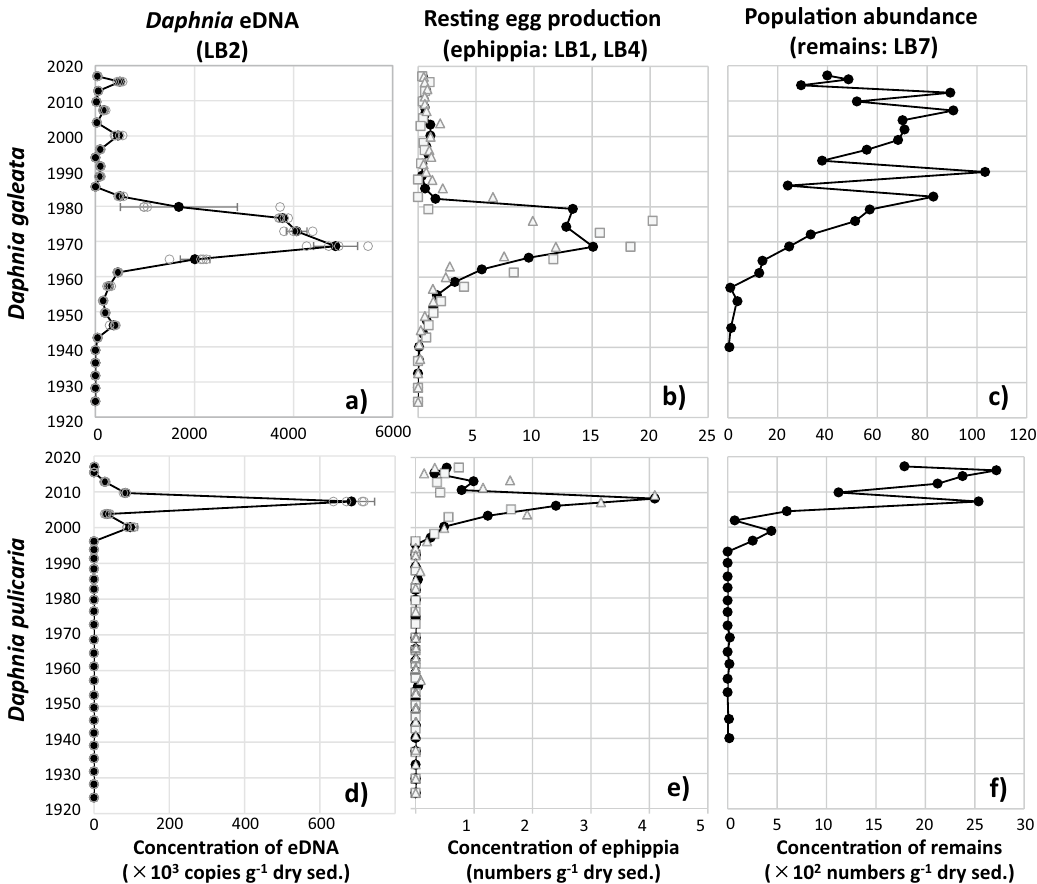
Figure 2. Temporal changes in sedimentary Daphnia DNA concentrations (copies of 12S rRNA gene g −1 of dry sediments; ( a , d ), ephippia ( b , e ); and remain ( c , f ) abundance (number g −1 of dry sediments). Data for Daphnia galeata in ( a )–( c ); and for Daphnia pulicaria in ( d )–( f ). For panels ( a ) and ( d ), the open circles indicate raw data, the black closed circles show the average mean ( n = 4), and the error bar of each data point denotes the SD. For panels ( b ) and ( e ), the grey square and triangles show the data of core LB1 and LB4, respectively, and the black circles indicate the average mean ( n =